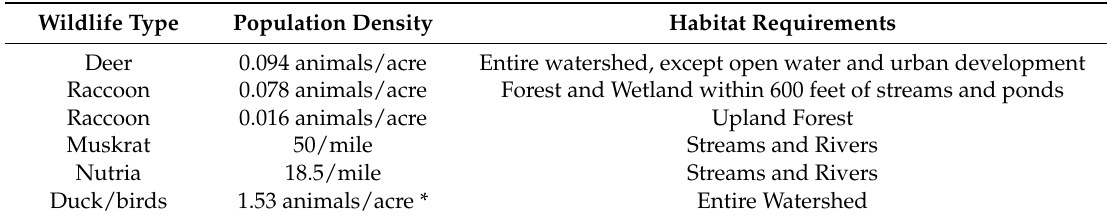
Table 1. Typical Wildlife Densities and Wildlife